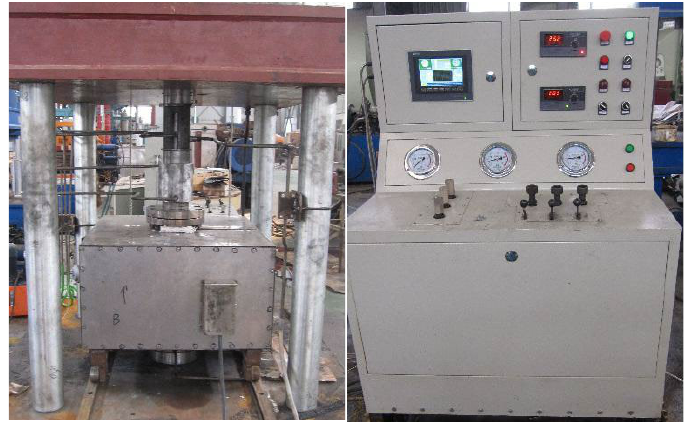
Figure 5. High-temperature triaxial penetration test device.